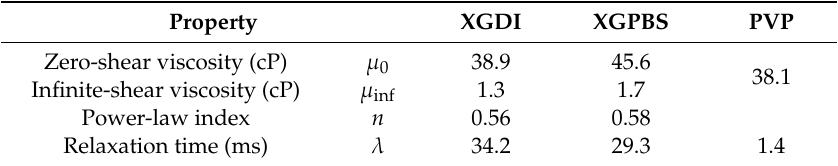
Table 1. Rheological properties of viscoelastic